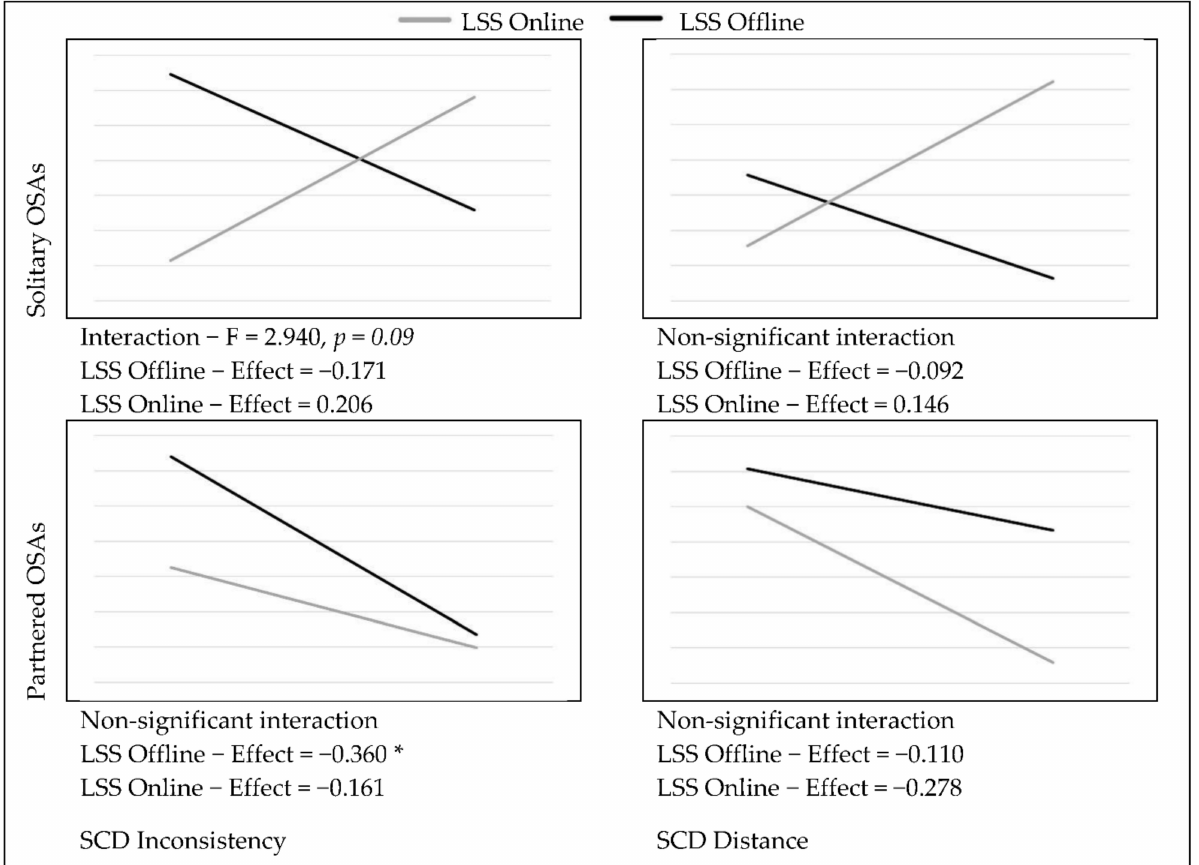
Figure 4. Effects of SCD on online sexual activities (standardized means). * p <